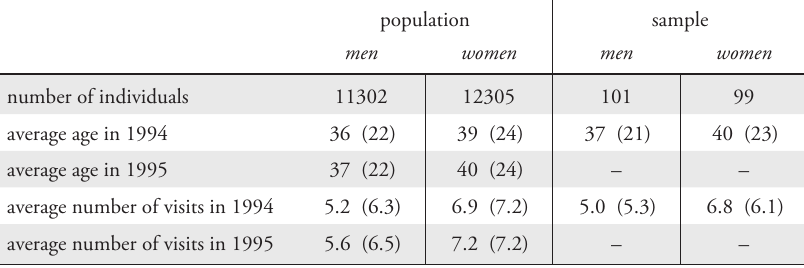
Table 2: Summary statistics, standard deviations in parentheses.